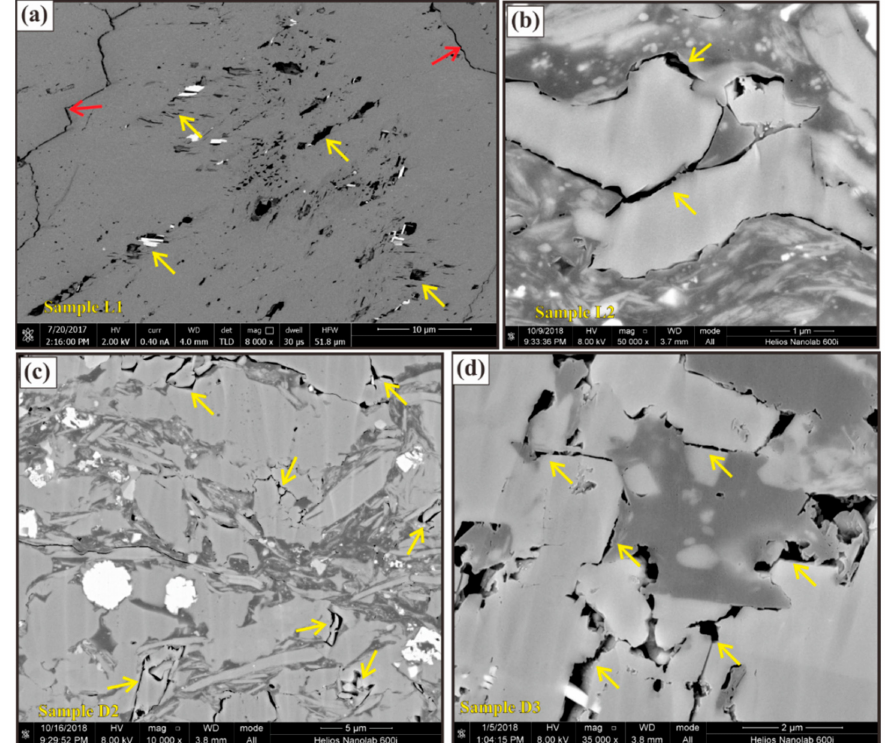
Figure 5. SEM photomicrograph images of interparticle pores in Lujiaping shales. Natural fracture- related pores are indicated with red arrows whereas the interparticle pores are indicated with yellow arrows. ( a ) SEM image showing abundant interparticle clay pores within sample L1; ( b ) SEM image showing abundant interparticle brittle mineral pores within sample L2; ( c ) SEM image showing abundant interparticle brittle mineral pores within sample D2; ( d ) SEM image showing abundant interparticle brittle mineral pores within sample